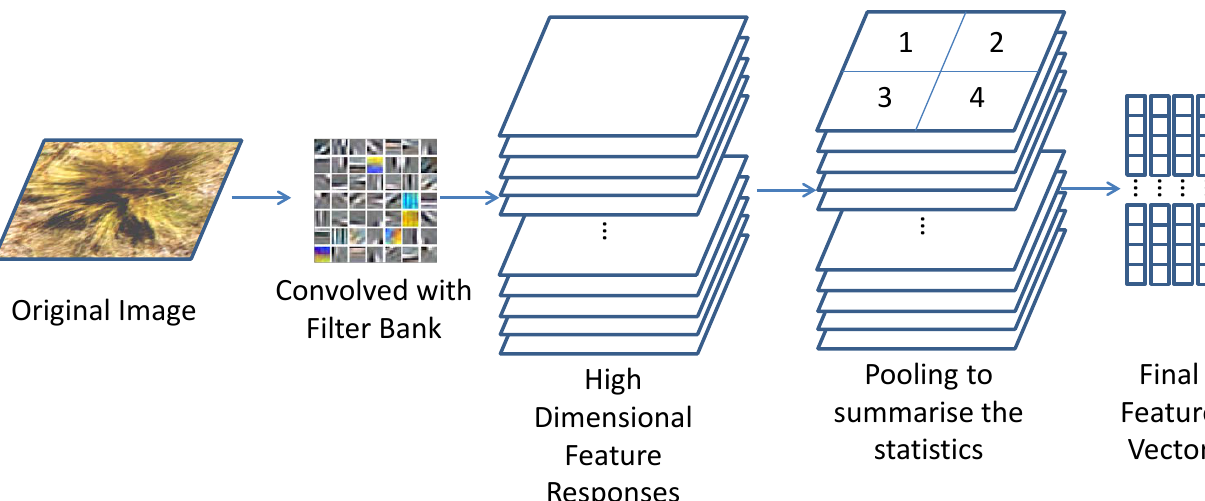
Figure 4. Feature extraction is performed by convolving the learned feature bank over the image. The high dimensional feature responses are then summarised using pooling before